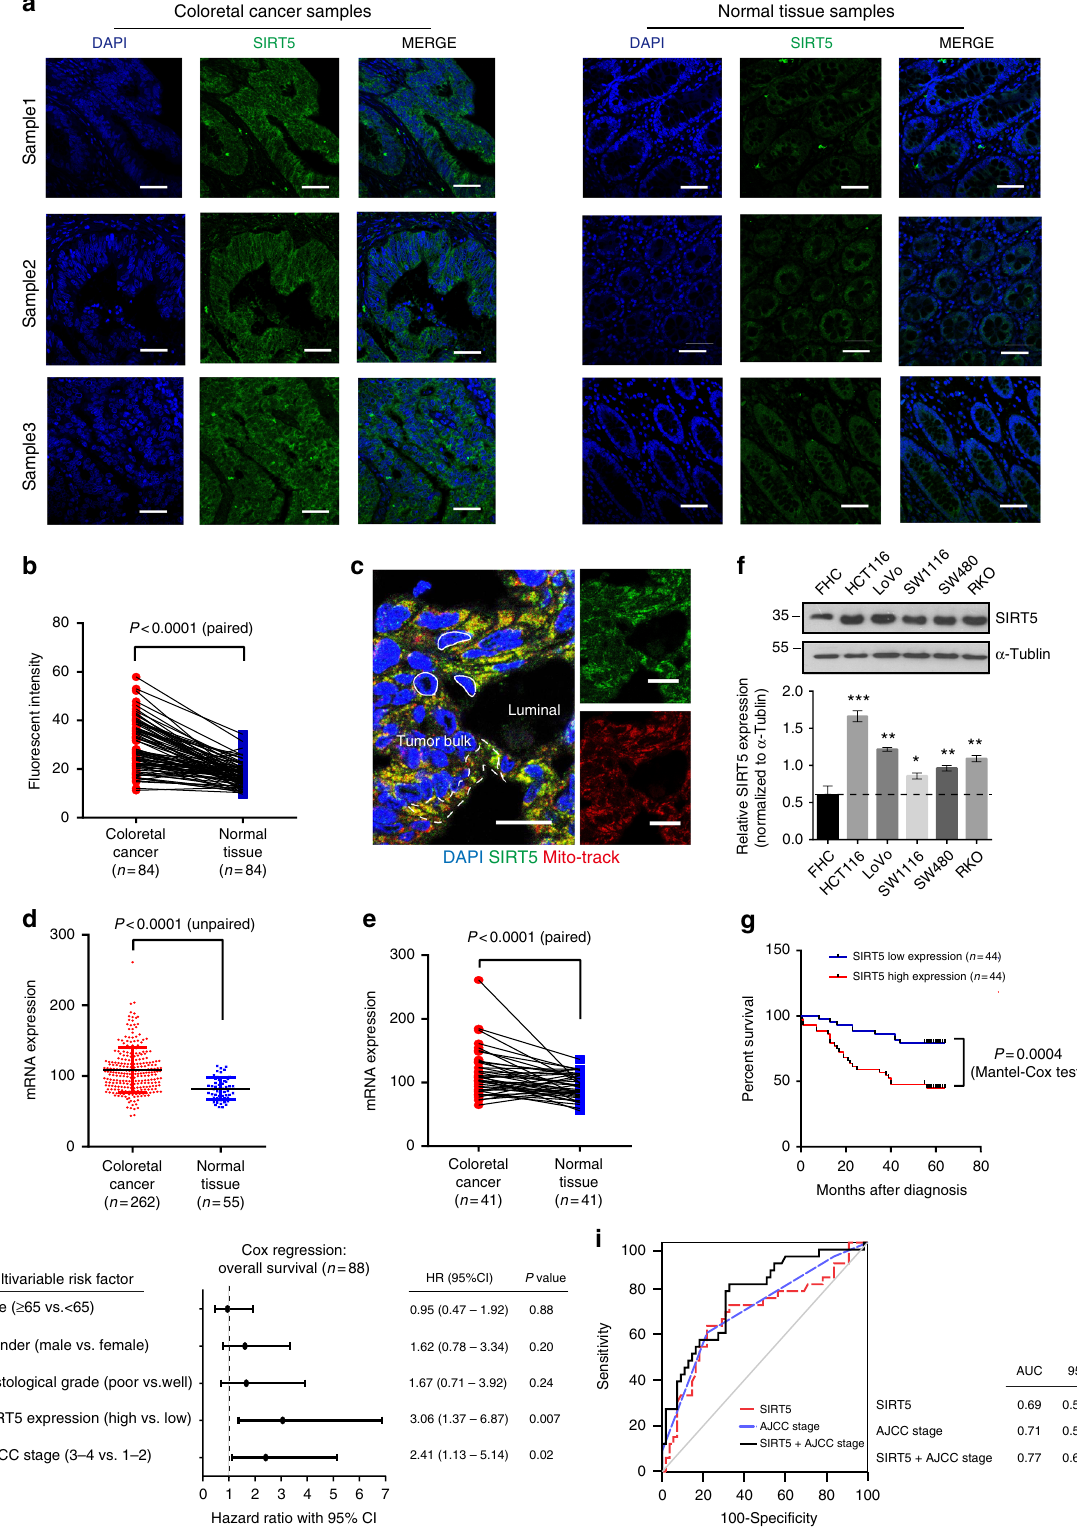
vs.well)Gender low)Histological grade (poor expression (high vs.